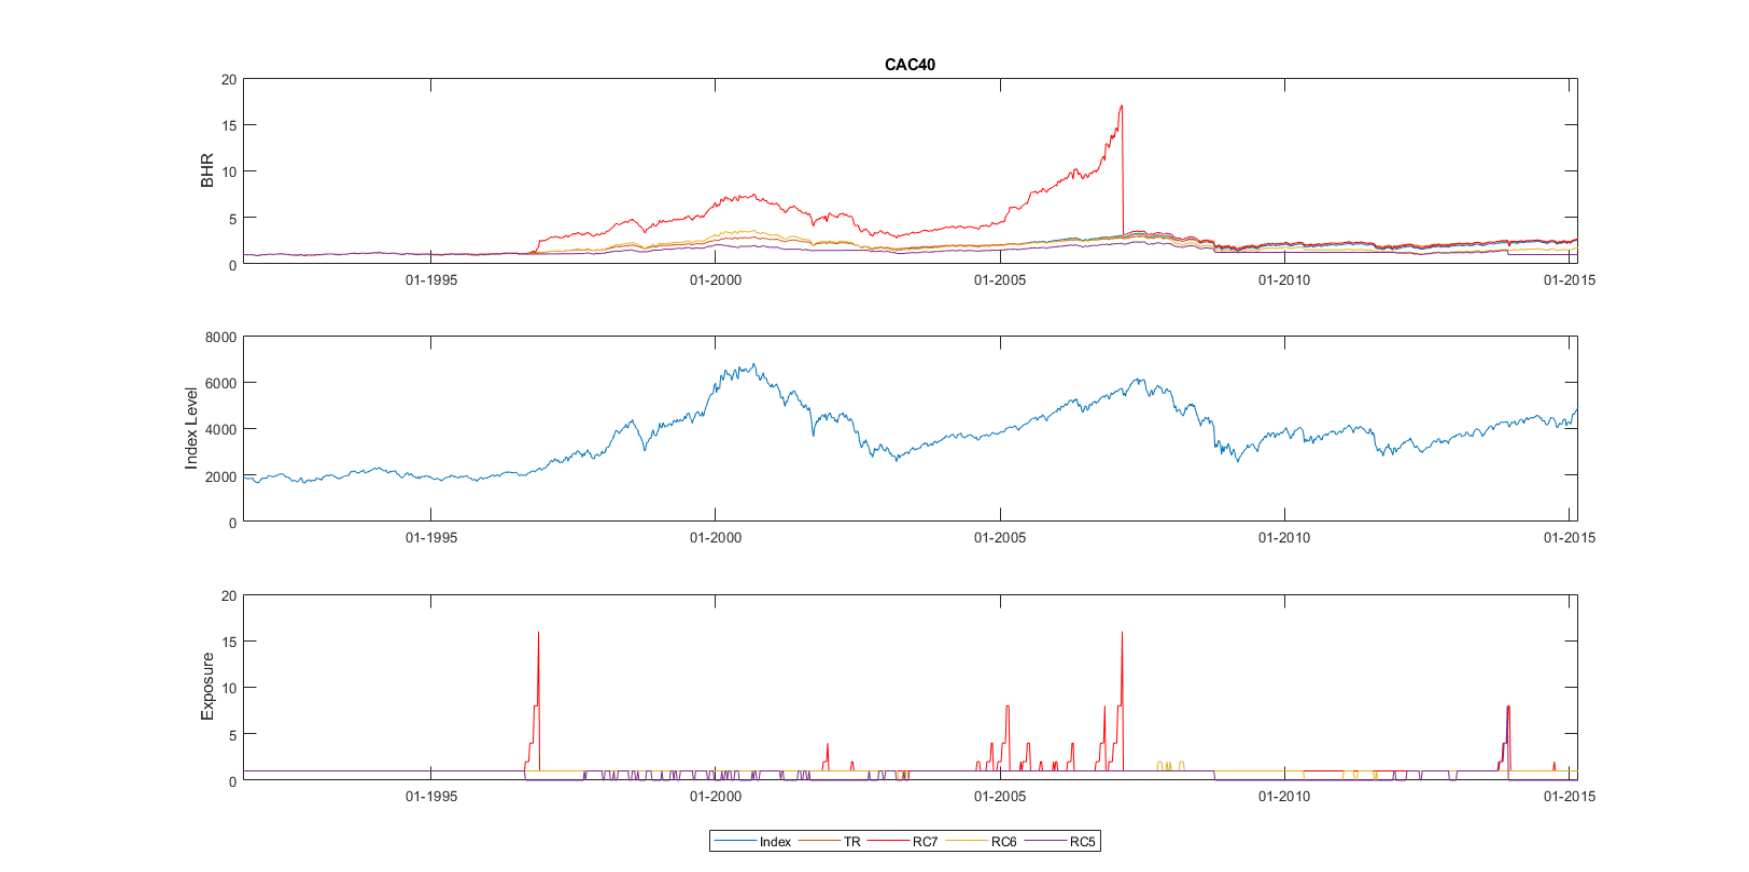
Figure 3. This figure displays the Buy and Hold returns (BHRs) of the volatility-based strategies, the index level and the exposures induced by the trading